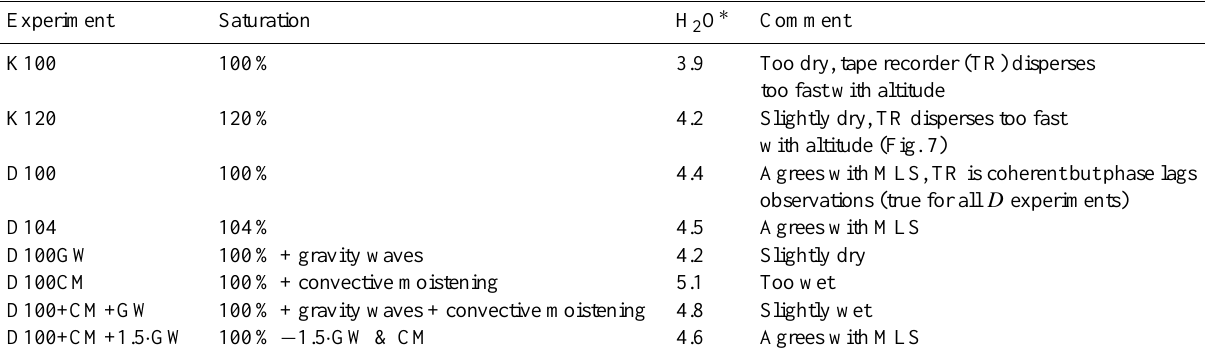
Table 1. Summary of trajectory experiments.